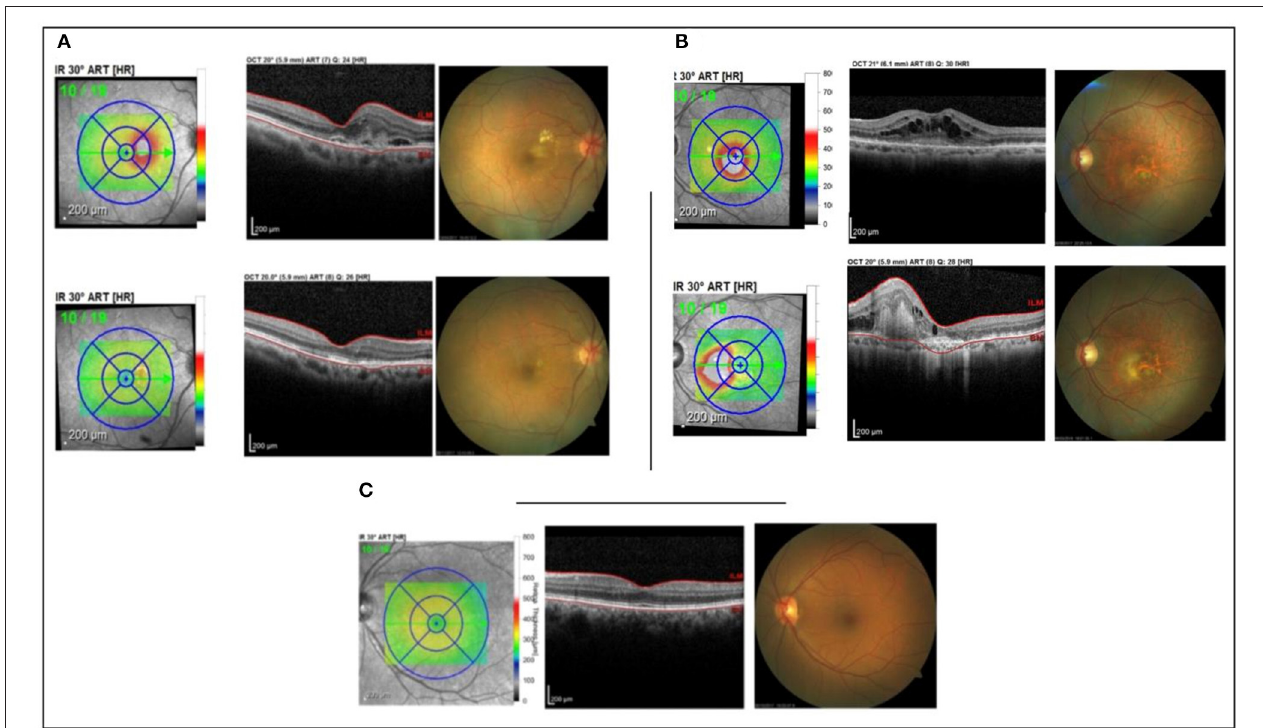
TABLE 1 | Clinical date of the groups of patients enrolled in the study. Age (yr) 72.8 ± 11.9 81.4 ± 4.3 73.0 ± 6.9 0.24 † Sex Female: 60%(3/5) Race White: 80% (4/5) Central Retinal Thickness (CRT), µ m 349.8 ± 99.2 334.6 ± 94.2 289 ± 6.7 0.58 † Visual-acuity Decimal notation and Snellen equivalent (R: right/L: left)